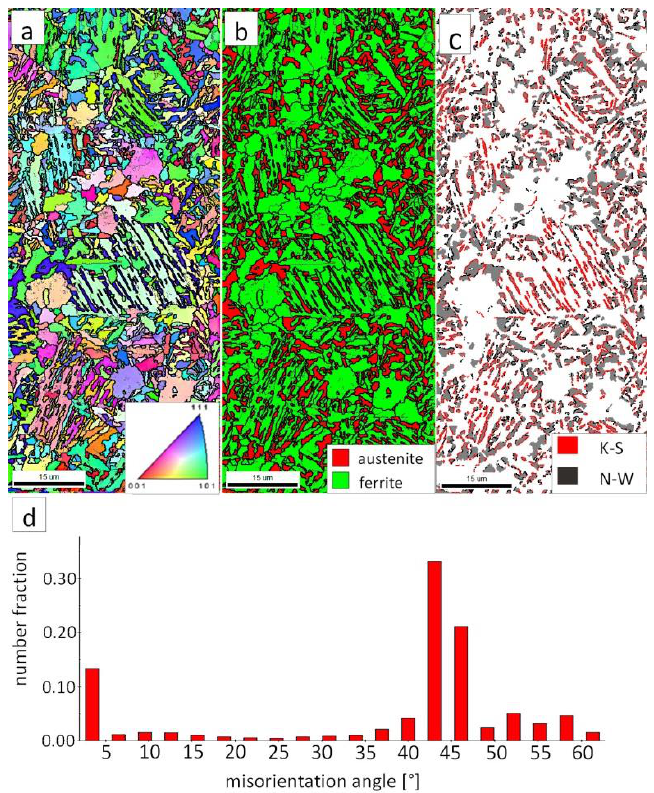
Figure 11. ( a ) IPF map of the HTHAZ area “C”. ( b ) Phase distribution map of the HTHAZ area “C”. ( c ) Phase distribution map with indicated boundaries of N-W (marked in black) and K-S (marked in red) orientations. Ferrite-white, austenite-gray. ( d ) Misorientation angles distribution of the HTHAZ region “C”.